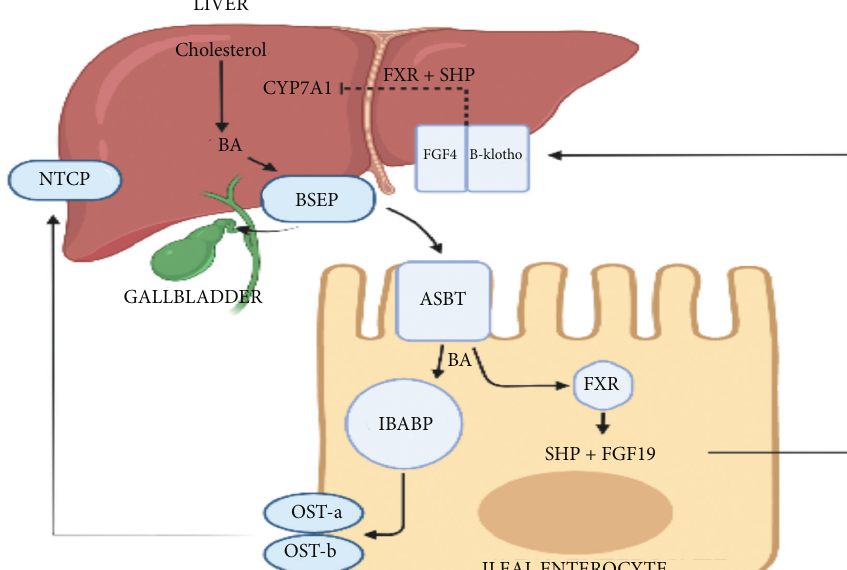
Figure 3: Bile acid signalling within the enterocyte. Bile acids are formed from the breakdown of cholesterol via the CYP7A1 enzyme. Bile acids are then transported from the liver through the bile salt export pump (BSEP). They will then travel via the biliary tree to the gallbladder for storage. After a meal, bile acids are then ejected into the small intestine where they are actively absorbed into the brush border of the terminal ileal epithelial cell through the apical bile acid transporter (ASBT). In the cytoplasm of the enterocyte, bile acids bind to the ileal bile acid binding protein (IBABP) and then are excreted via the basolateral heterodimeric protein OSTalpha and beta. Bile acids enter the portal venous circulation and return to the liver via the Na+-taurocholate polypeptide (NTCP). In the enterocyte and hepatocyte, bile acids will bind to FXR-activating FGF19 and SHP. These proteins will then travel to the liver to create a negative feedback pathway and inhibit further bile acid synthesis (image created by